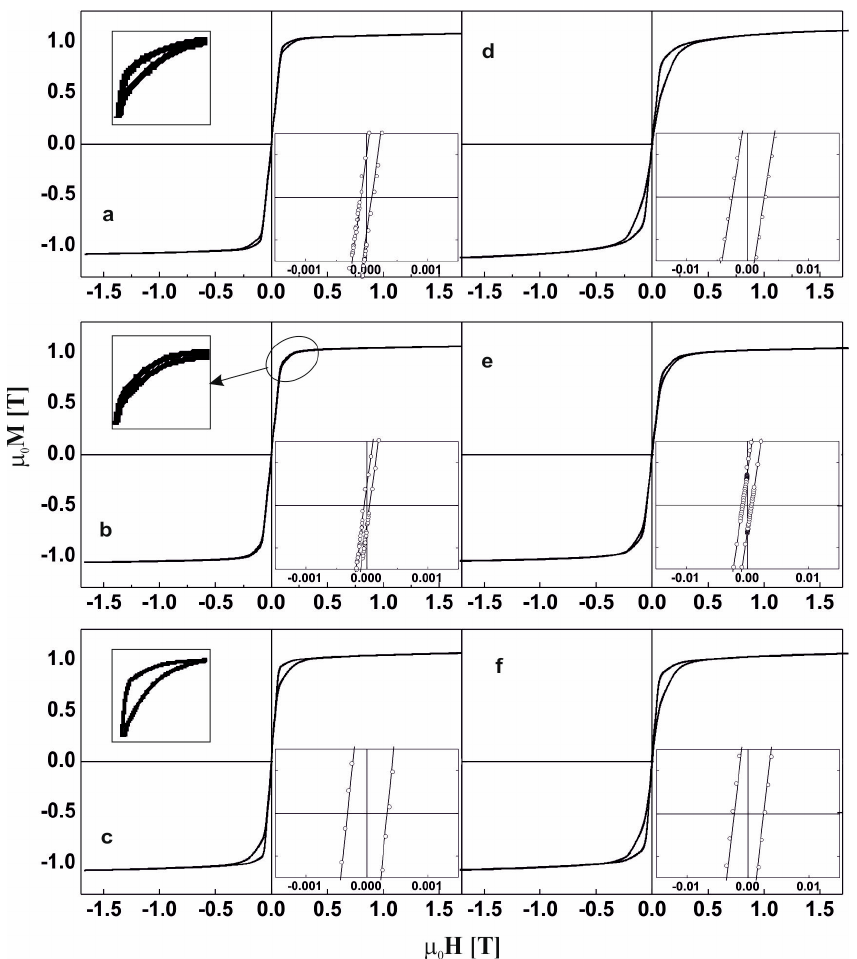
Figure 7. The static magnetic hysteresis loops for the alloys in the as-cast state ( a – c ) and after the thermal treatment at 940 K for 10 min ( d – f ) made by the injection-casting method: Fe 61 Co 10 W 1 Y 8 B 20 , ( a , d ), Fe 62 Co 9 W 1 Y 8 B 20 , ( b , e ) Fe 63 Co 8 W 1 Y 8 B 20 ( c , f